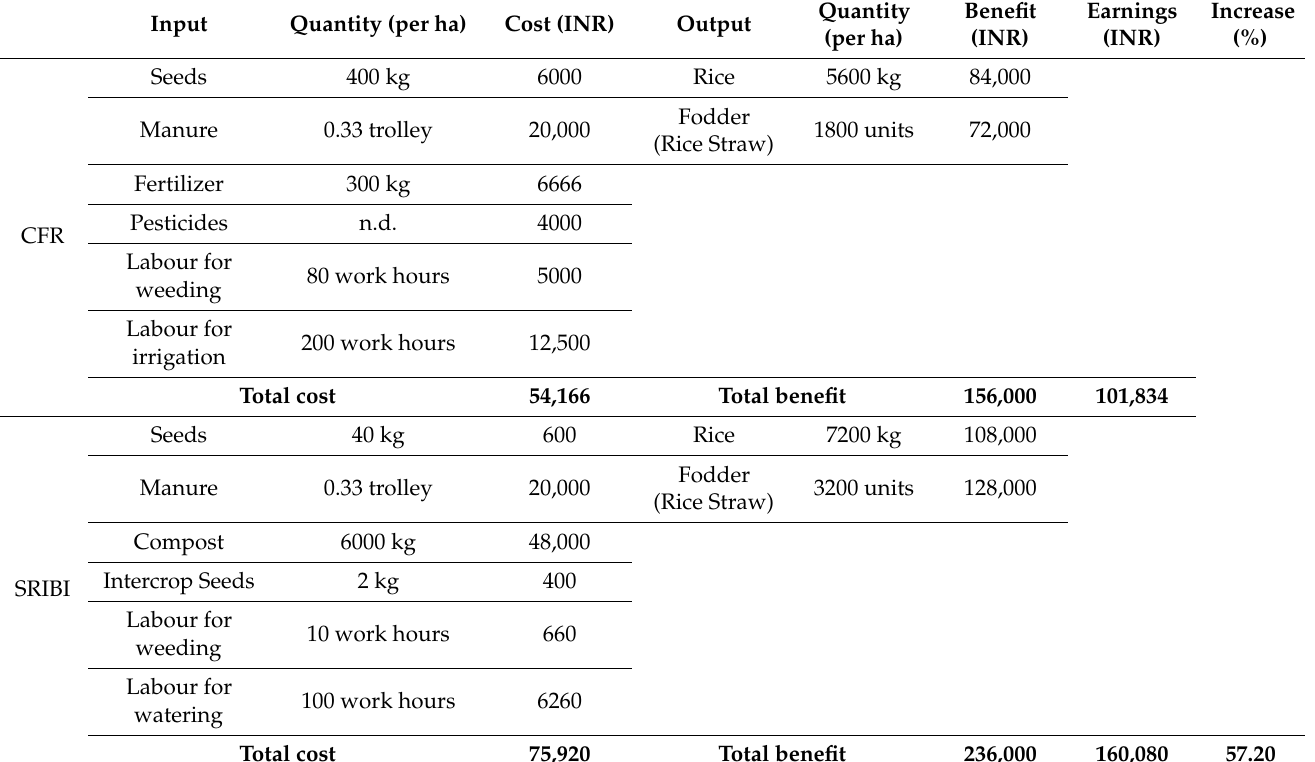
Table 10. Economic balance sheet of the innovations implemented during the course of